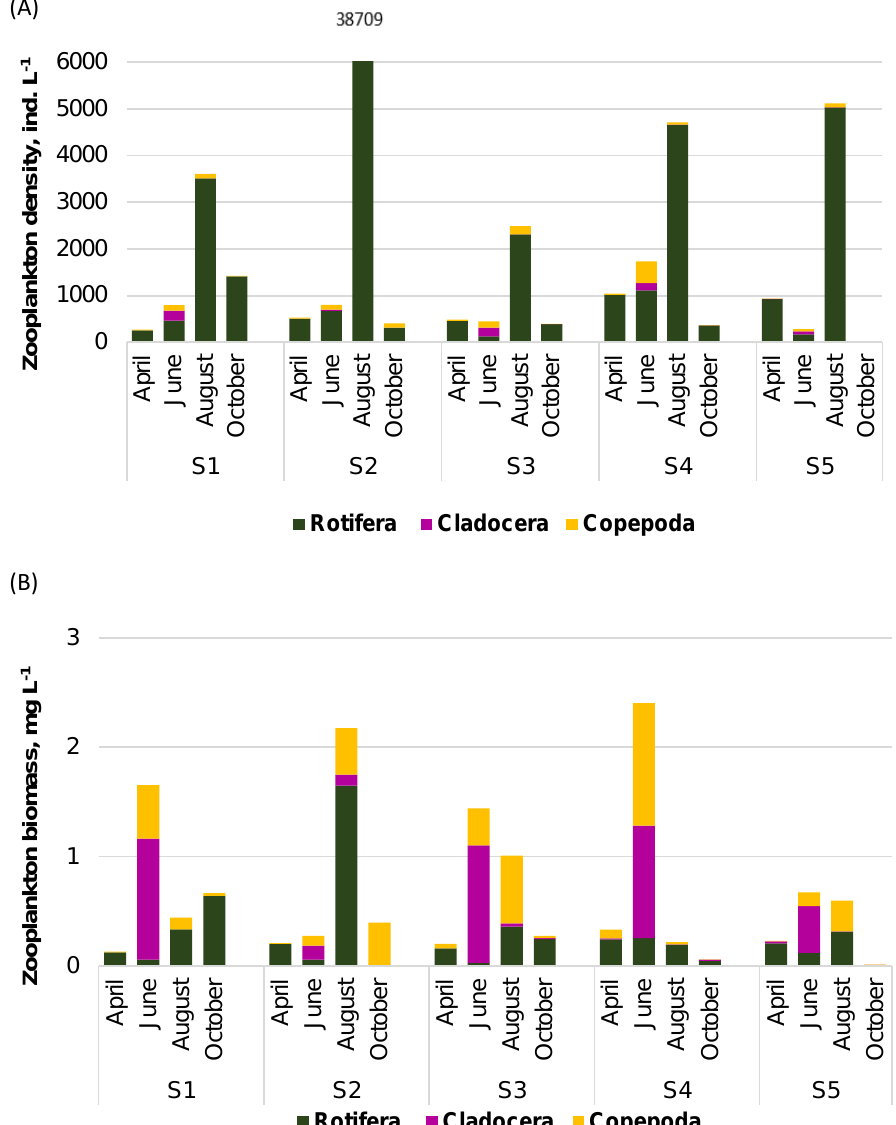
Figure 5. Spatial distribution of zooplankton density ( A ) and biomass ( B ) in surface waters of Lake Sztynorckie. Sampling sites: S1—profundal zone; S2—inflow zone; S3—channel zone; S4—fuel zone; S5—mooring zone.